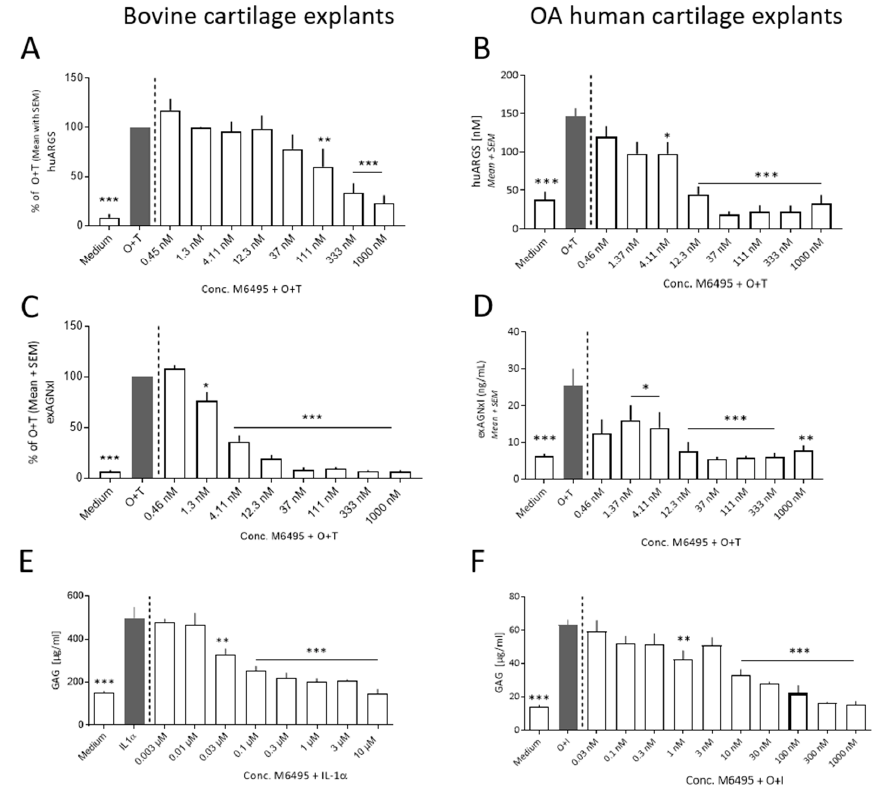
Figure 2. Aggrecan turnover in bovine cartilage explants and OA human cartilage explants at day 5 of culture. ( A , B ): ADAMTS-5 derived aggrecan degradation (huARGS). ( C , D ): MMP-derived aggrecan degradation (exAGNx1). ( E , F ): Glycosaminoglycan (GAG) release. The bovine cartilage